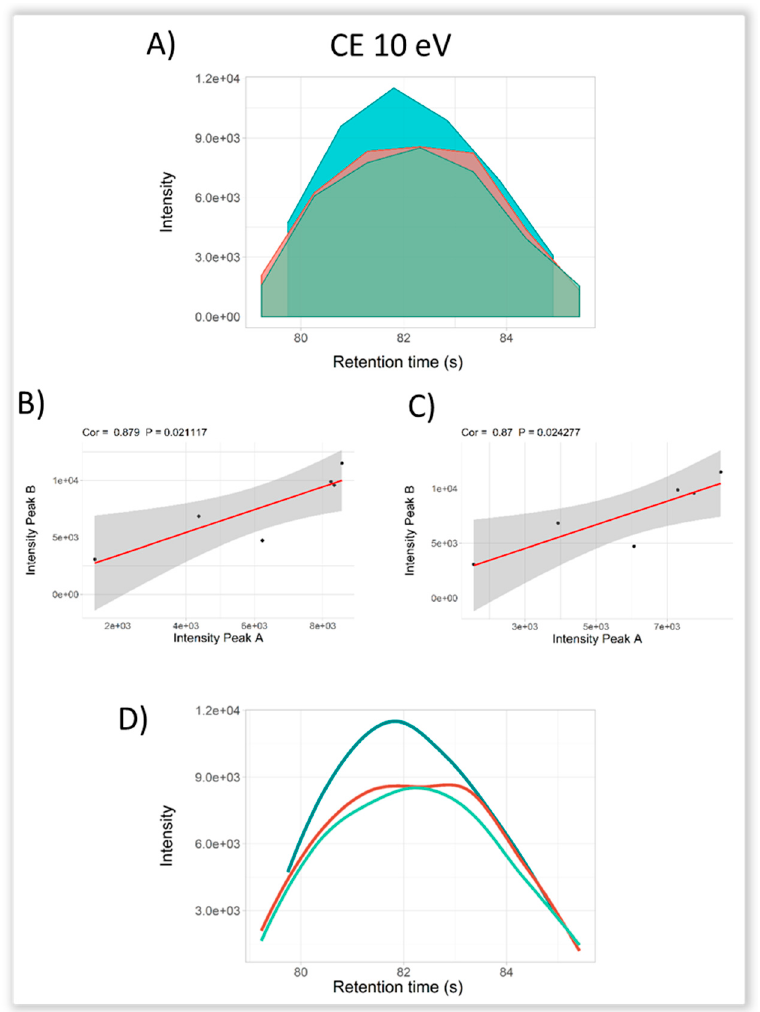
Figure 3. Peak visualization and statistical evaluation of glutamine characterized by LC-qTOF data independent acquisition (DIA)-MS/MS with the ScoresDIA.R function. Coelution profile for the EIC (extracted ion chromatogram) generated is plotted and followed by analysis of the peak-to-peak Pearson correlation (PPC) and peak-to-peak shape (PPS) ratio for the product/precursor ions. ( A ) Coelution profile for the precursor 147.0764 m/z and fragments 130.0499 m/z and 84.0444 m/z annotated as glutamine [M+H] + obtained at 10 eV. ( B ) Peak-to-peak Pearson correlation analysis for 84.0444 m/z fragment with precursor ion. ( C ) Peak-to-peak Pearson correlation analysis for 130.0499 m/z fragment with precursor ion. ( D ). Smoothed coelution plot for PPC and PPS analysis. For phenylacetylglutamine, at CE 5 eV only 84.0444 and 130.0499 m/z fragments were found that